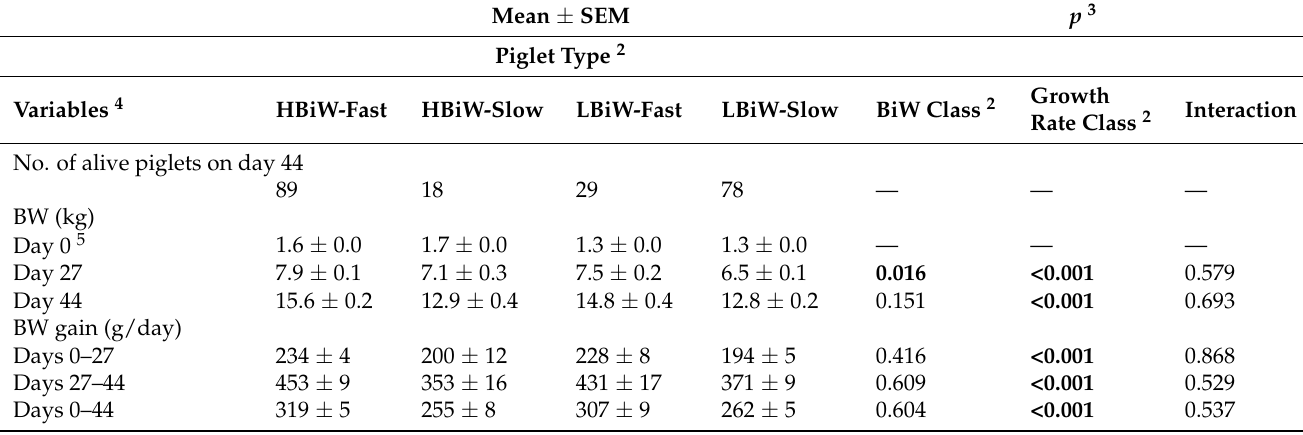
Table 2. Body weight (BW), BW gain, nutrient intake, feeding behaviours, suckling behaviours, skin lesions, and genetics in four types of focal piglets 1 i.e., HBiW-fast, HBiW-slow, LBiW-fast and LBiW-slow up to day 44 of lactation in the multi-suckling (MS) system. Mean ± SEM p